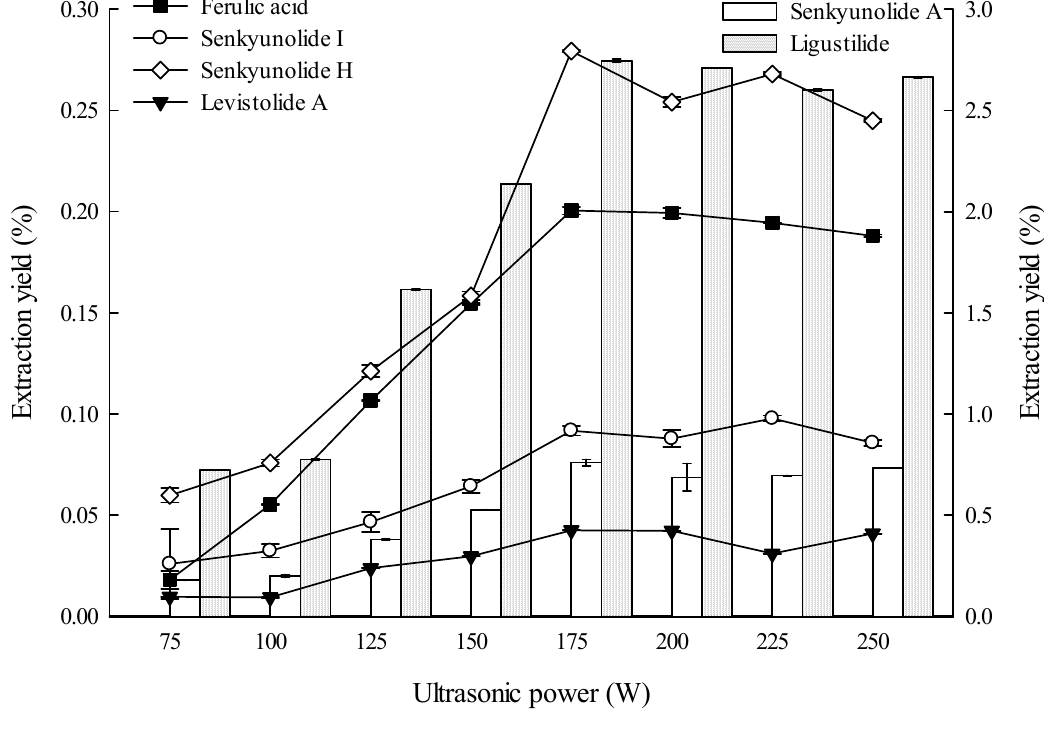
Figure 6. Effect of ultrasonic power on the extraction yields of the six constituents (the lines and bar graphs are referenced to the left and right axes, respectively).